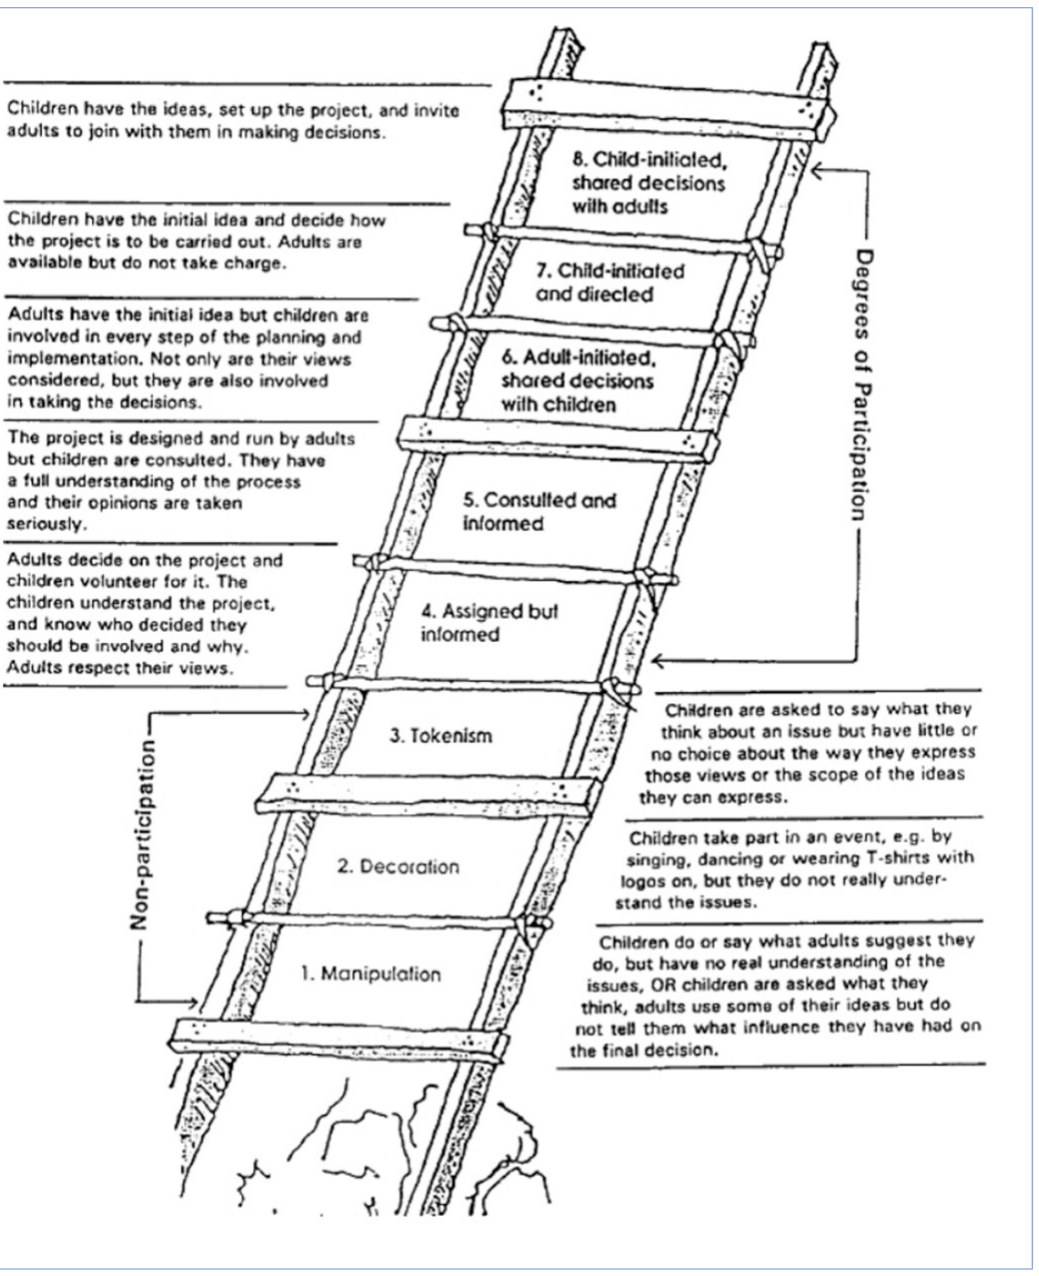
Figure 1. Hart’s (1992) Ladder of